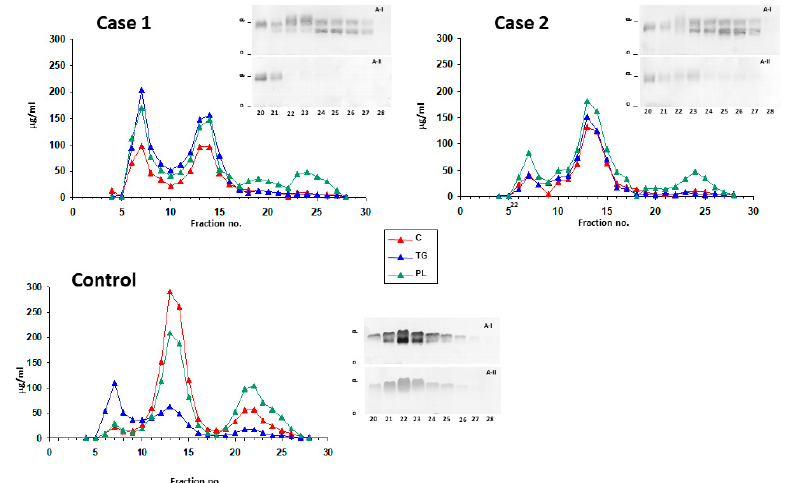
Figure 3. Plasma Gel Filtration Fast Protein Liquid Chromatography (FPLC) analysis. Plasmas were subjected to FPLC, as described in Methods, and the concentrations of cholesterol (C), triglyceride (TG) and choline-containing phospholipids (PL) were determined in the indicated fractions. Inserts: the indicated fractions corresponding to HDL were concentrated, and subjected to agarose gel electrophoresis and immunoblotting for apo A-I and apo A-II. The profiles corresponding to the first case ( A ), second case ( B ) and control subjects ( C ) are presented.